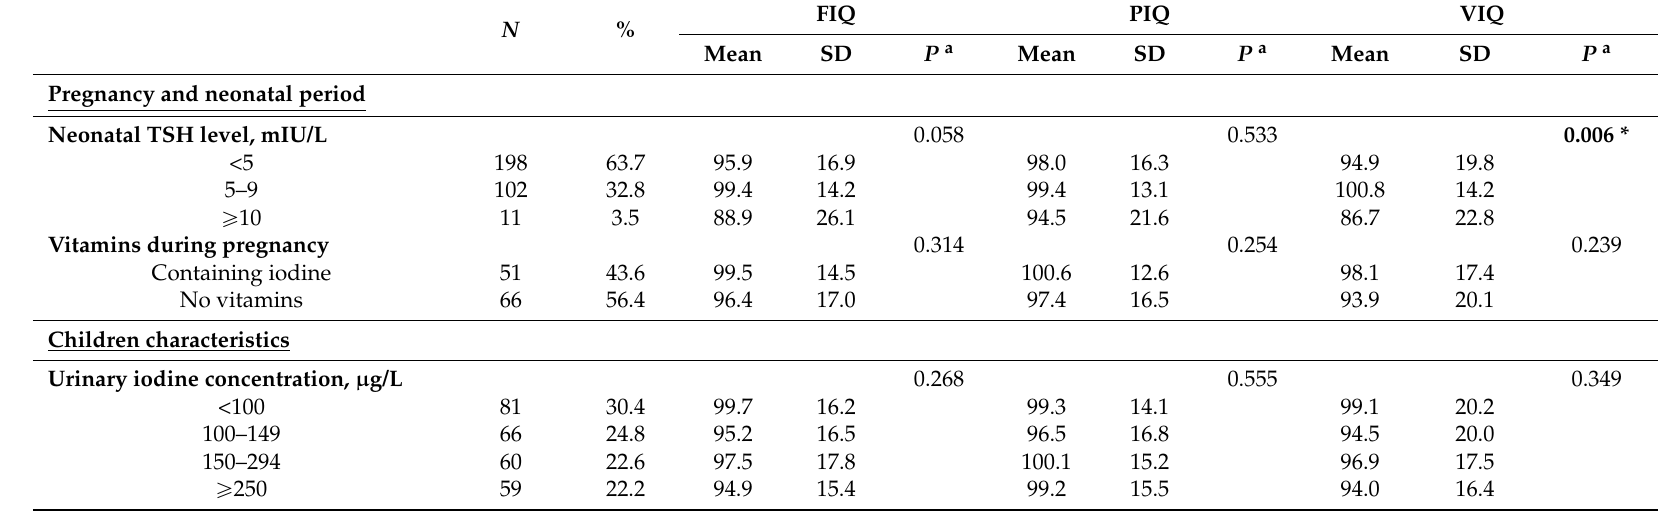
Table 4. Cognitive scores at preschool age and markers of iodine status. PsychoTSH study, Belgium,